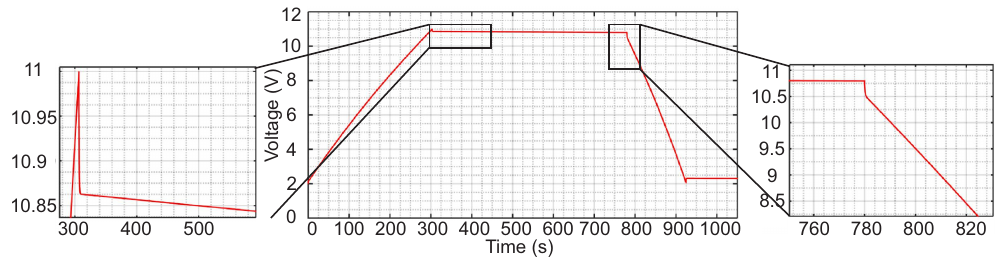
Figure 11. Capacitor voltage during charging and